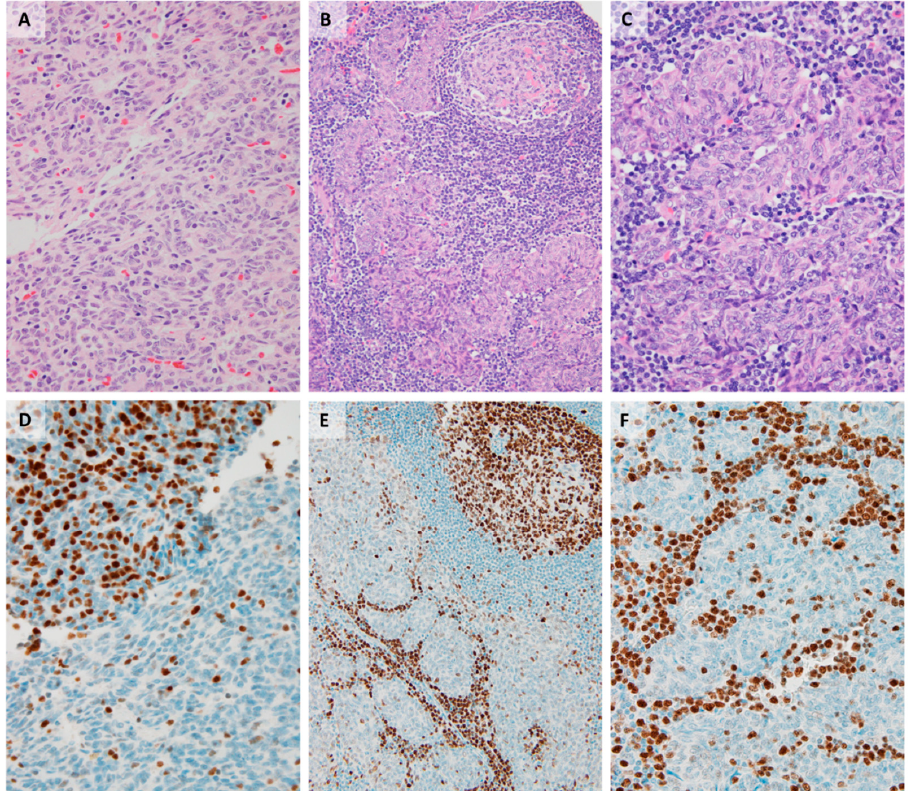
Figure 3. Hematoxylin and eosin ( A – C ) and EZH2 ( D – F ) immunostaining in a type A thymoma scored as <80% staining ( A , D ) and a micronodular thymoma with lymphoid stroma scored as <10% staining ( B , C , E , F ). Lymphocytes in ( E , F ) show patchy strong EZH2 staining. All images are at 400× magnification, except for ( B , E ) at 200× magnification.